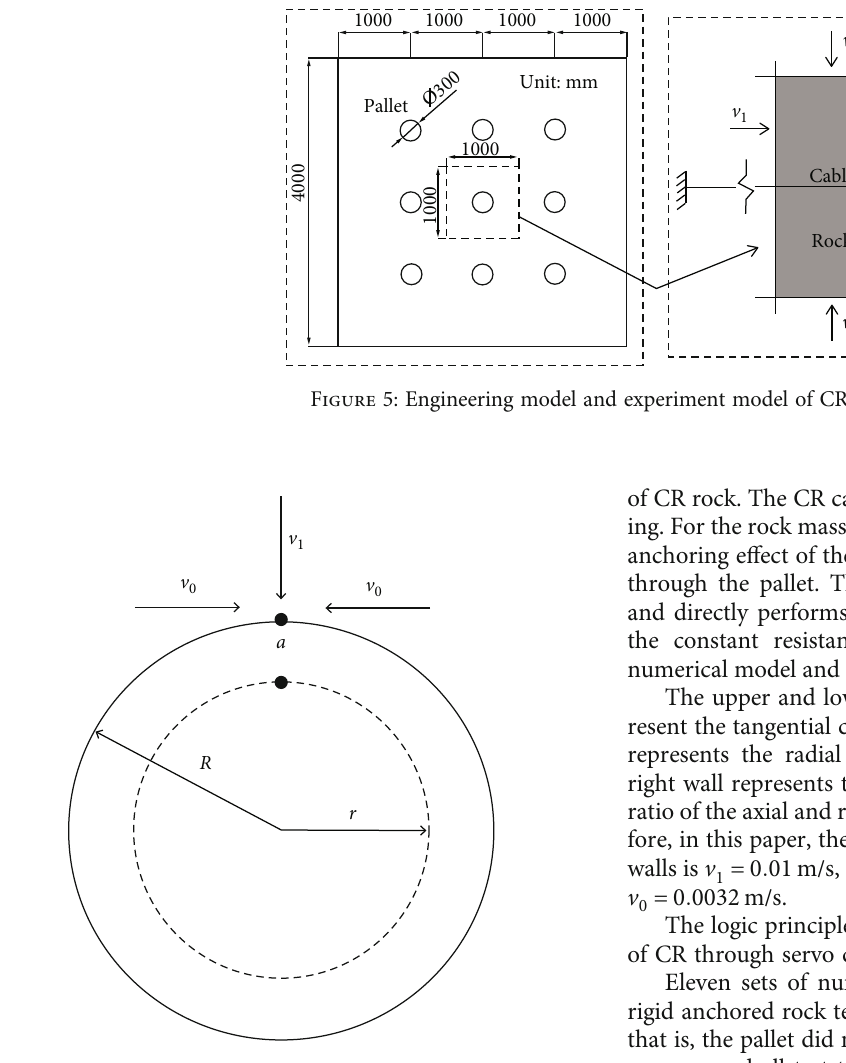
Figure 6: Loading speed at point a during tunnel